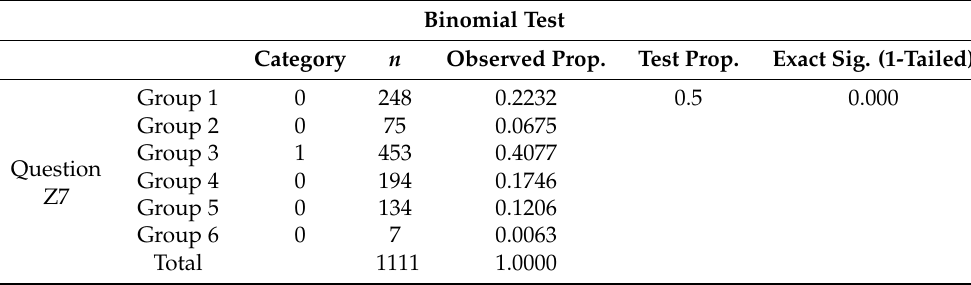
Table 6. Results of the binomial test to the Hypothesis H2—customers.